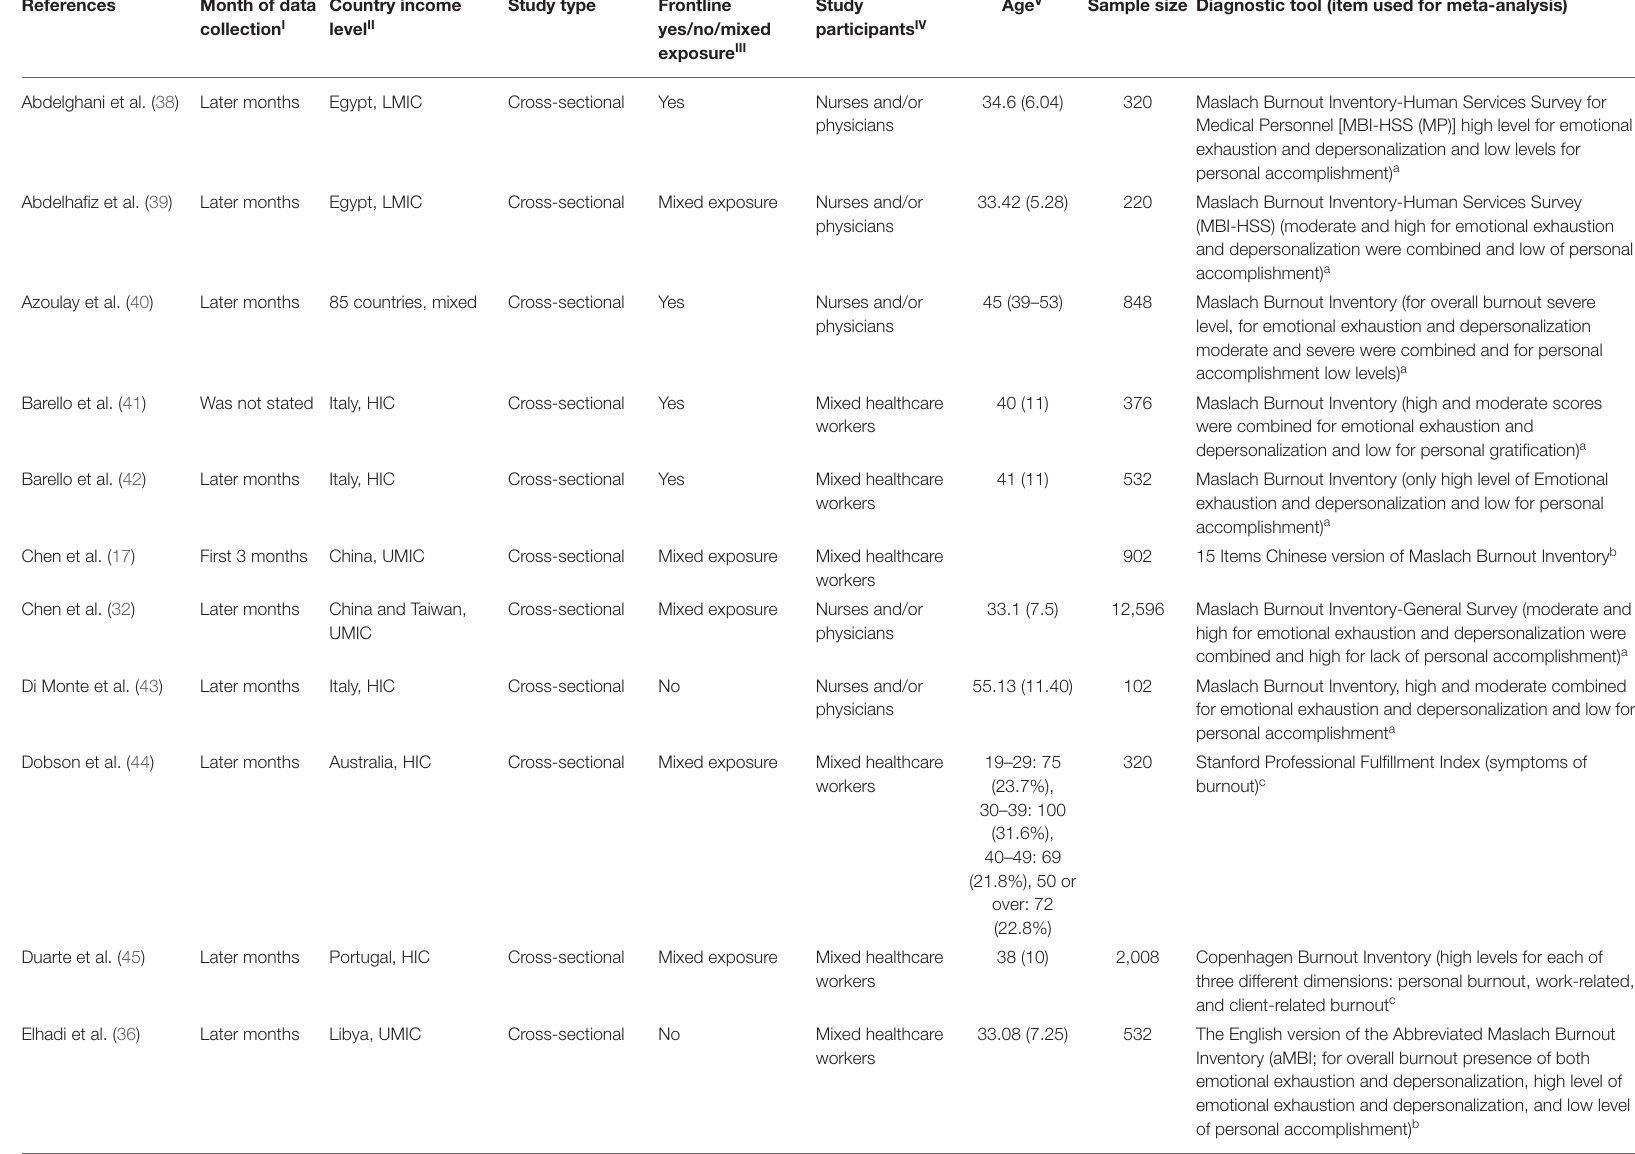
TABLE 1 | Characteristics of 30 studies included in systematic